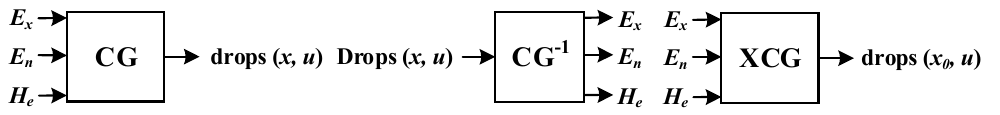
Figure 4. Process of forward cloud generators, backward cloud generators, and X-condition cloud generators.